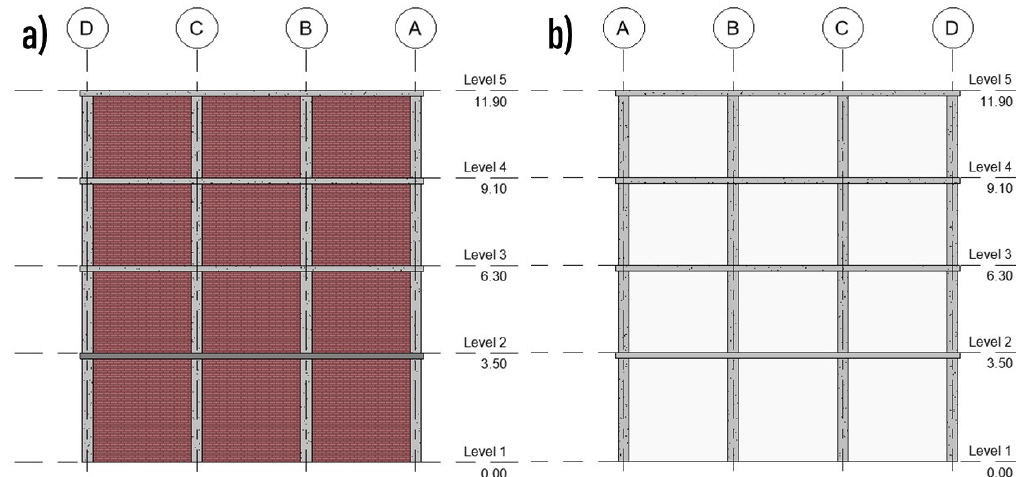
Figure 4. Typical plan of the studied building.